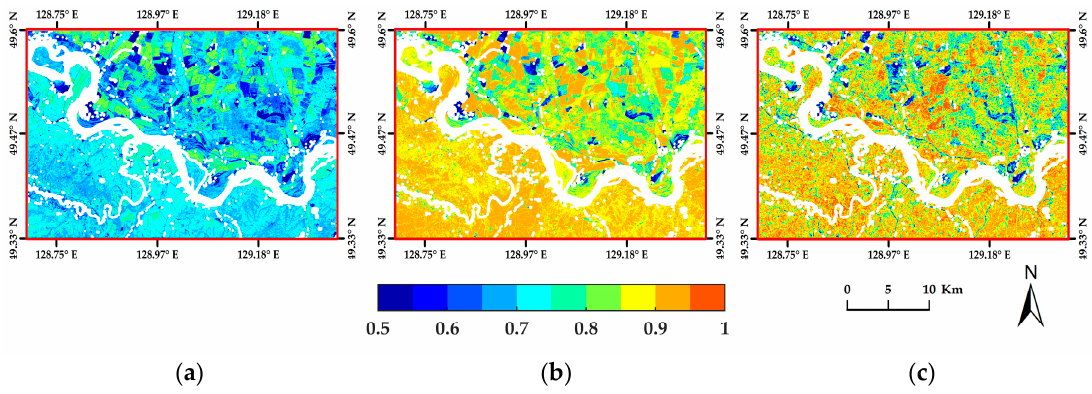
Figure 5. Comparisons between corrected image of NDVI and the corresponding uncorrected image. ( a ) NDVI derived from TOA reflectance and ( b ) surface NDVI derived from the Landsat 8 surface reflectance products and ( c ) atmospheric corrected NDVI by using NP algorithm. Fields covered by river which are excluded during algorithm implementation appear with white color. ( a ) NDVI TOA: mean = 0.708; ( b ) NDVI SR: mean = 0.868; ( c ) NDVI NP: mean = 0.862.